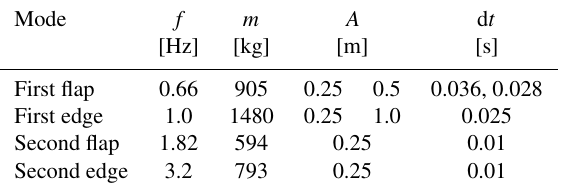
Table 1. Modal parameters and time steps prescribed in the work comparison. The time steps for the first flap were chosen as 180 steps per revolution and thus depend on the rotor